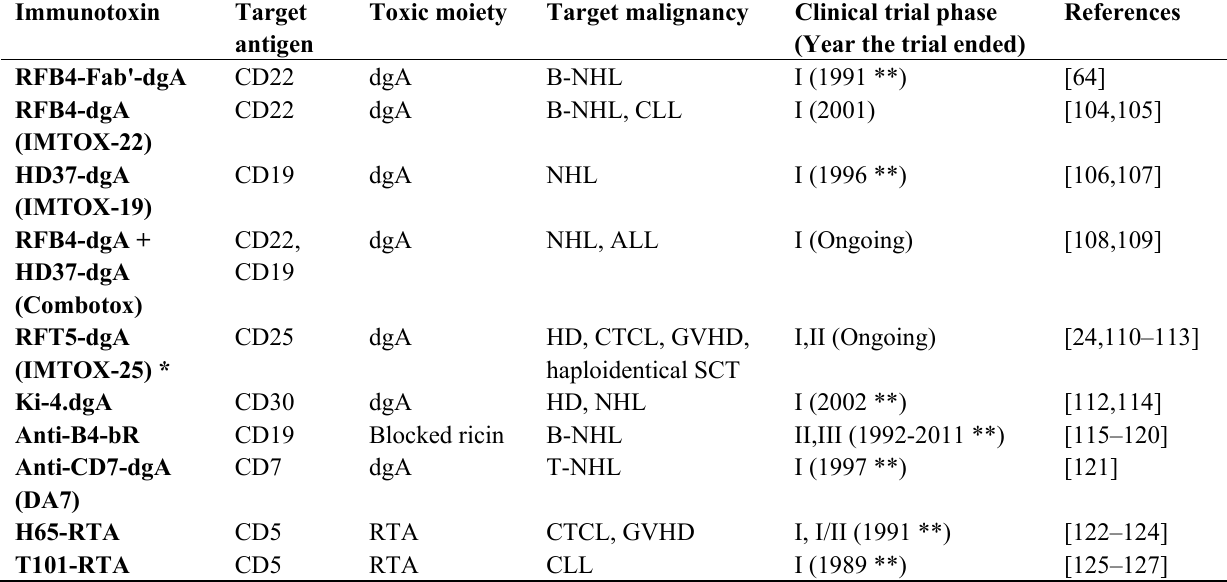
Table 3. Clinically evaluated/under evaluation RT-based immunotoxins against hematologic malignancies.